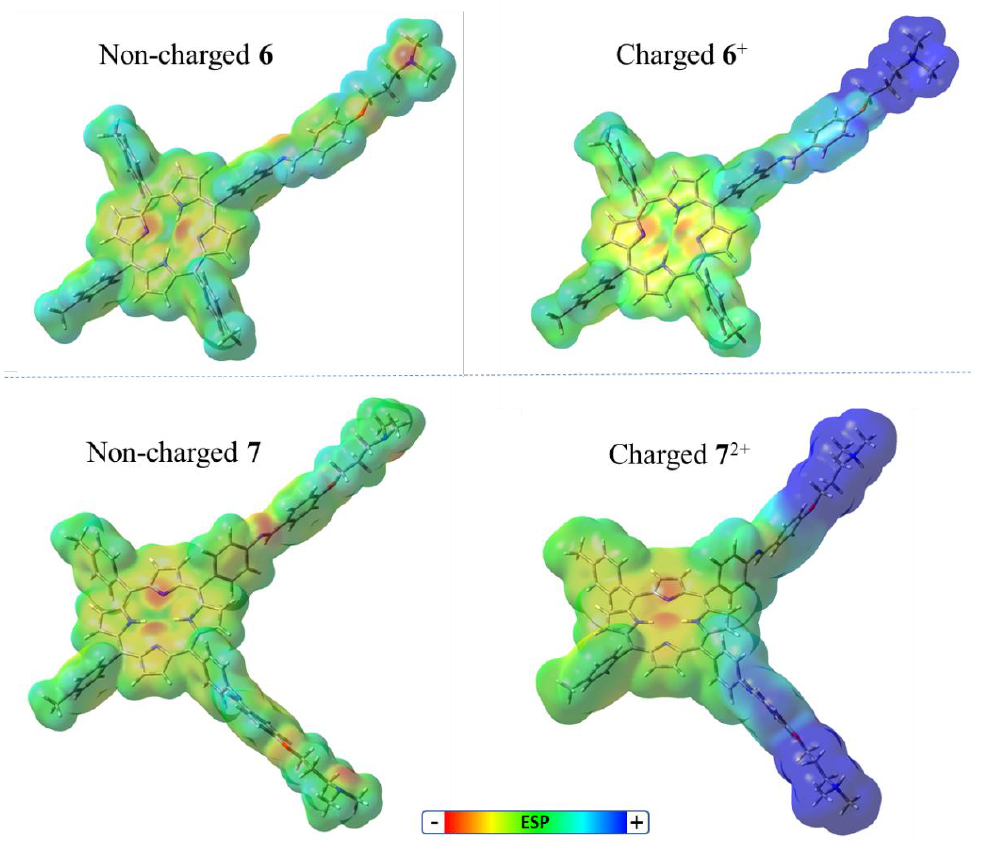
Figure 1. Optimized structure and the ESP surfaces of non-charged 6 and 7 and protonated analogs 6 + and 7 2+ calculated for ground state by using DFT at the B3LYP/6-31G(d) level. Created in Avogadro Software founded on Gaussian 09 calculations. The positive and negative ESP regions are colored blue and red, respectively.